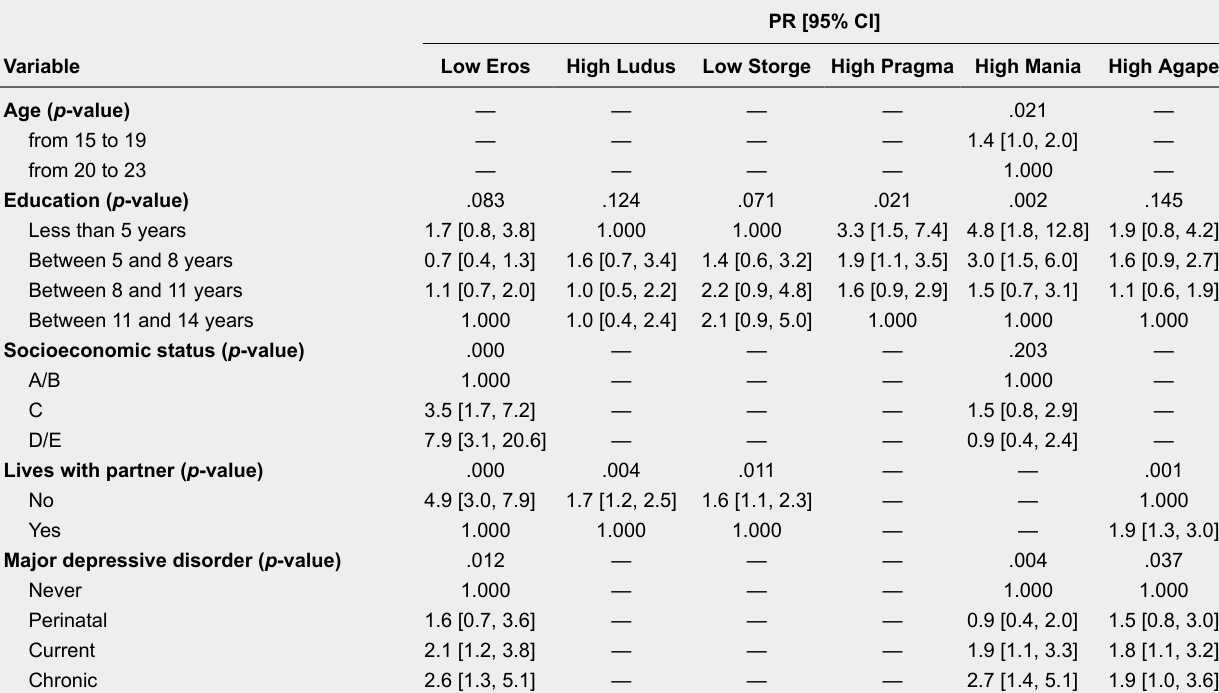
Adjusted Analysis Demonstrating the Impact of Socioeconomic Variables and MDD on the Six Love